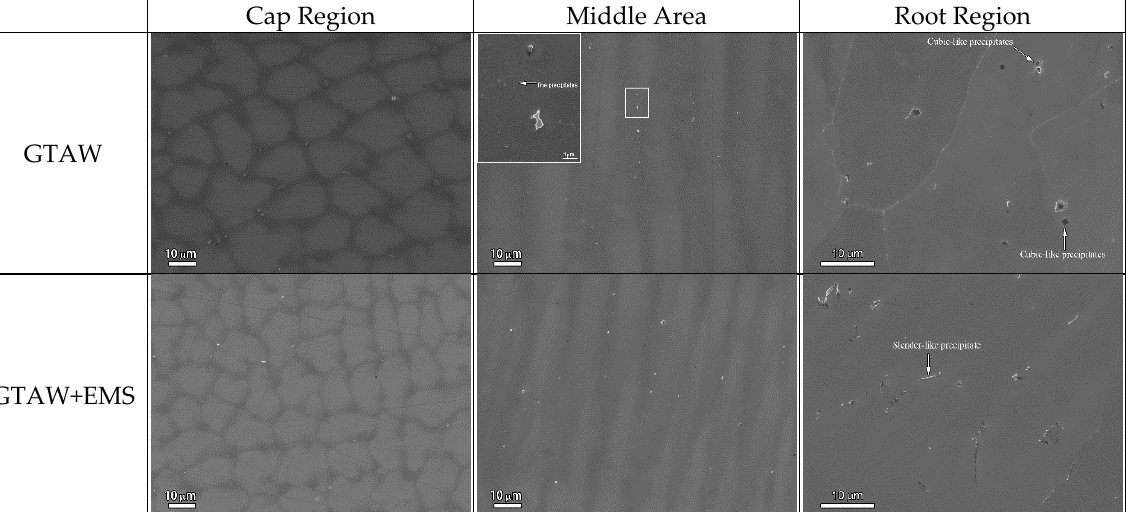
Figure 8. scanning electron microscope (SEM) micrographs of Alloy 52.